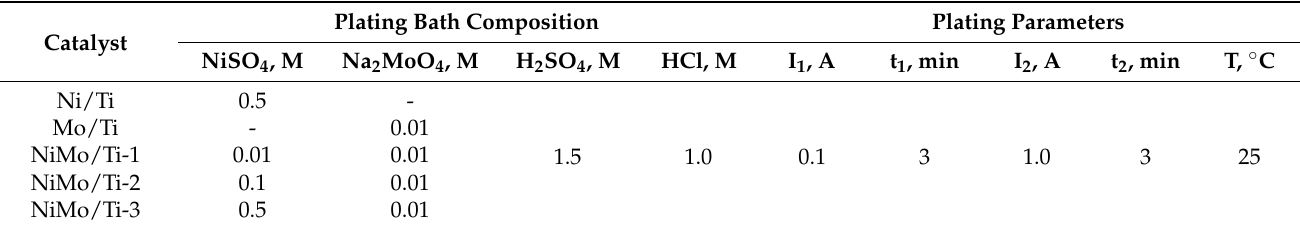
Table 4. The composition of plating baths and parameters for the deposition of Ni, Mo, and NiMo